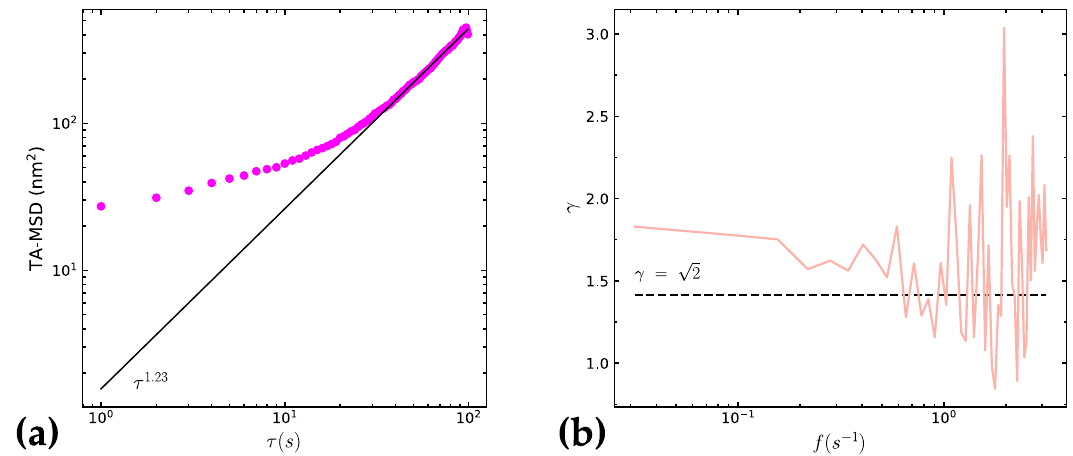
Fig. 6 Mean squared displacement (MSD) and coef fi cient of variation for superdiffusive nanoparticles in hMSCs. a MSD showing a superdiffusive regime with large deviations due to the presence of the static localisation error. b The coef fi cient of variation con fi rms the